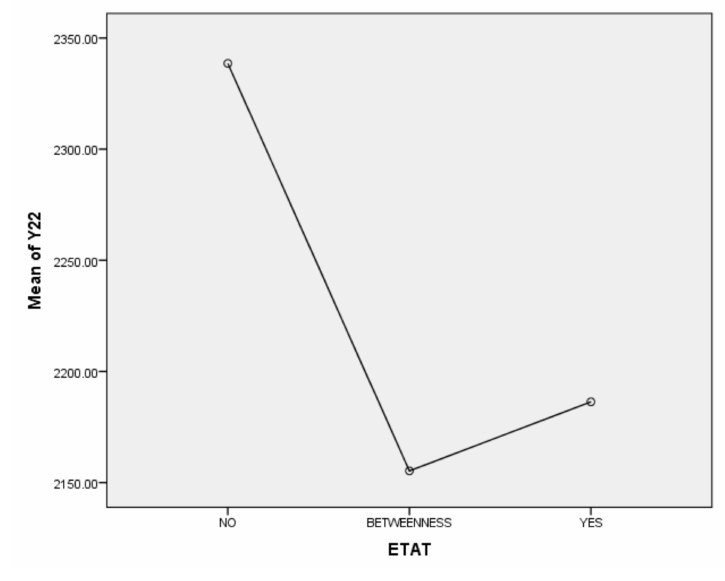
Figure 11. Per capita income and its growth rate in ETAT areas (1990–2018). Note: The red dots in the chart show that the annual growth rate increased (the hosting year of the ETAT). The green dot is negative.